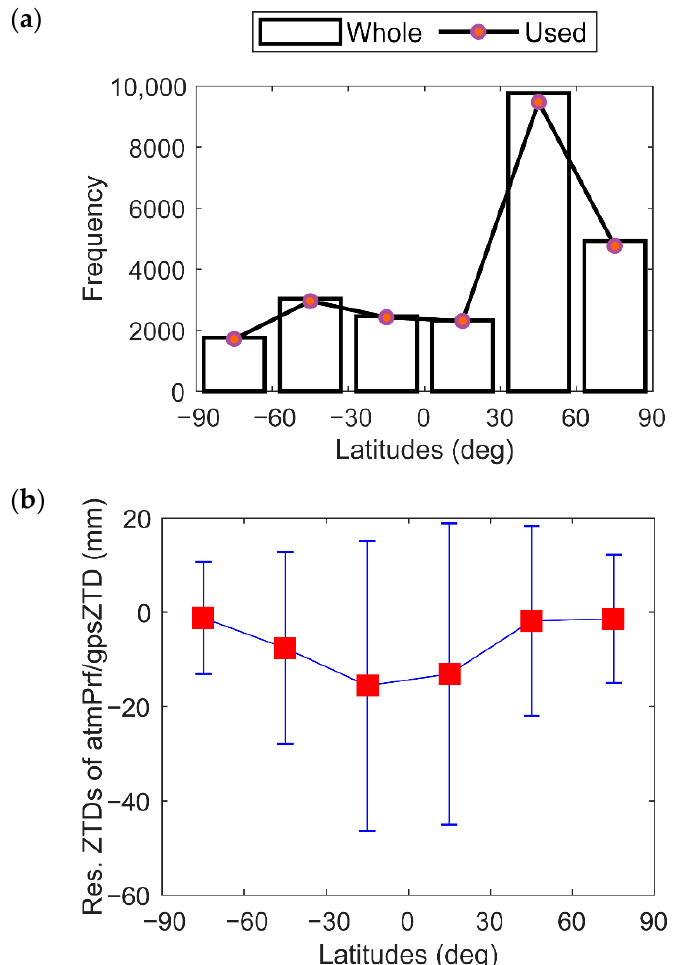
Figure 11. Latitudinal variations in ( a ) occultation event frequency; and ( b ) residual ZTDs of matched atmPrf and gnsZTD in 2008.